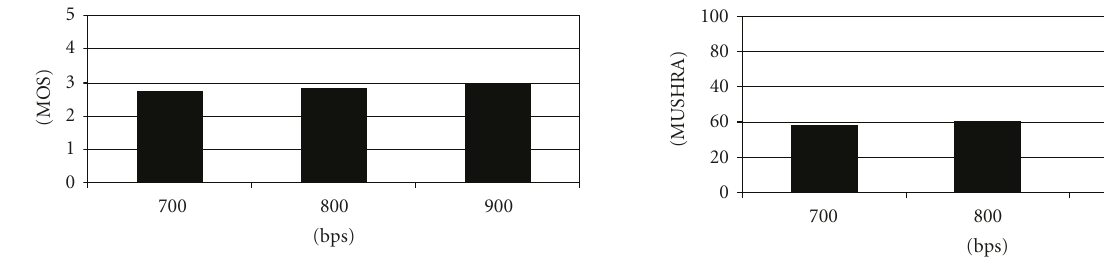
Figure 7: MOS score at three di ff erent rates. Scores of 2.71, 2.82, and 2.92 are achieved for 700, 800, and 900bps, respectively.